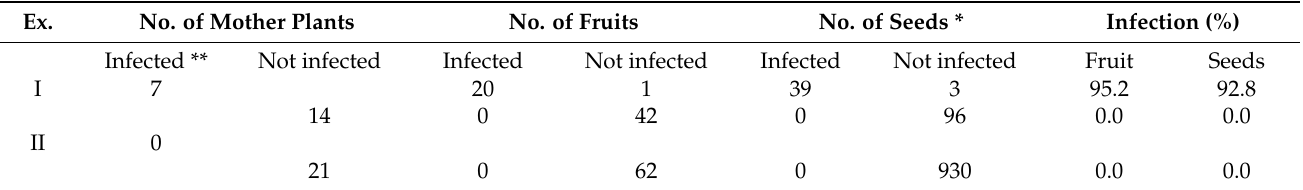
Table 1. ToBRFV transmission by the cross-pollination of noninfected tomato mother plants with pollen from infected